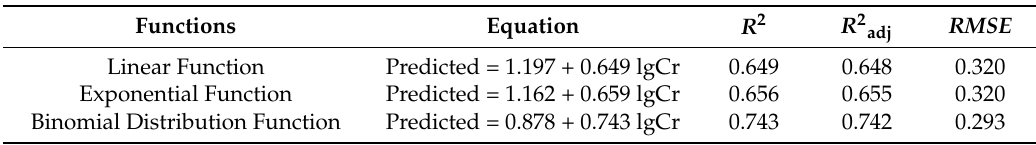
Table 2. The R 2 and root mean square error ( RMSE ) values for different distribution functions. Functions